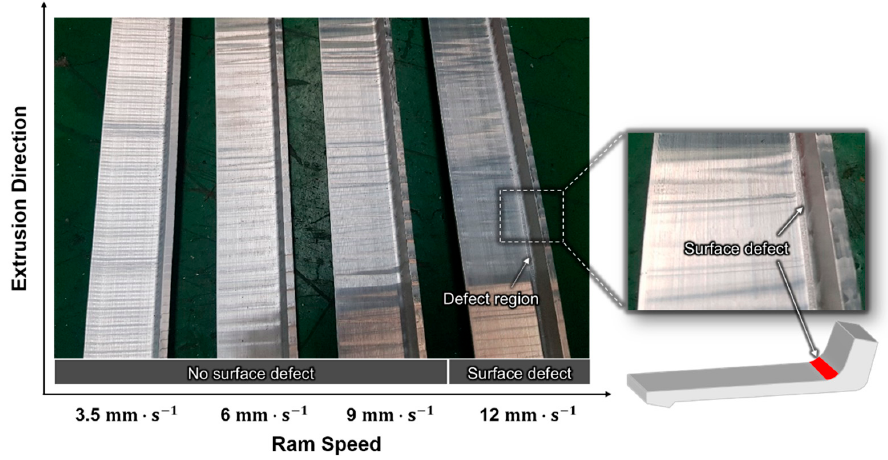
Figure 13. L-shaped samples extruded at various ram speeds.